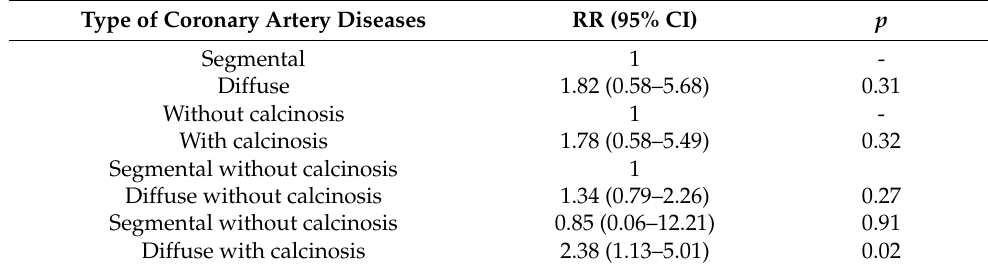
Table 4. The relative risk of adverse outcomes one year after surgery depending on the phenotype of coronary artery